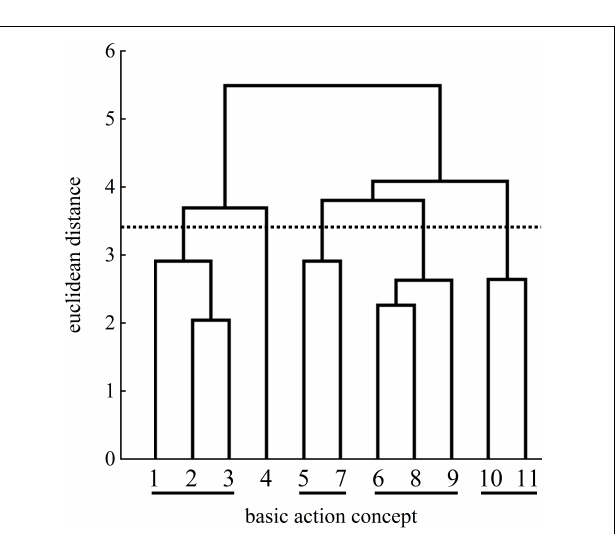
FIGURE 5 | Mean group dendrogram of the analogy group’s ( n = 15) tennis serves on the